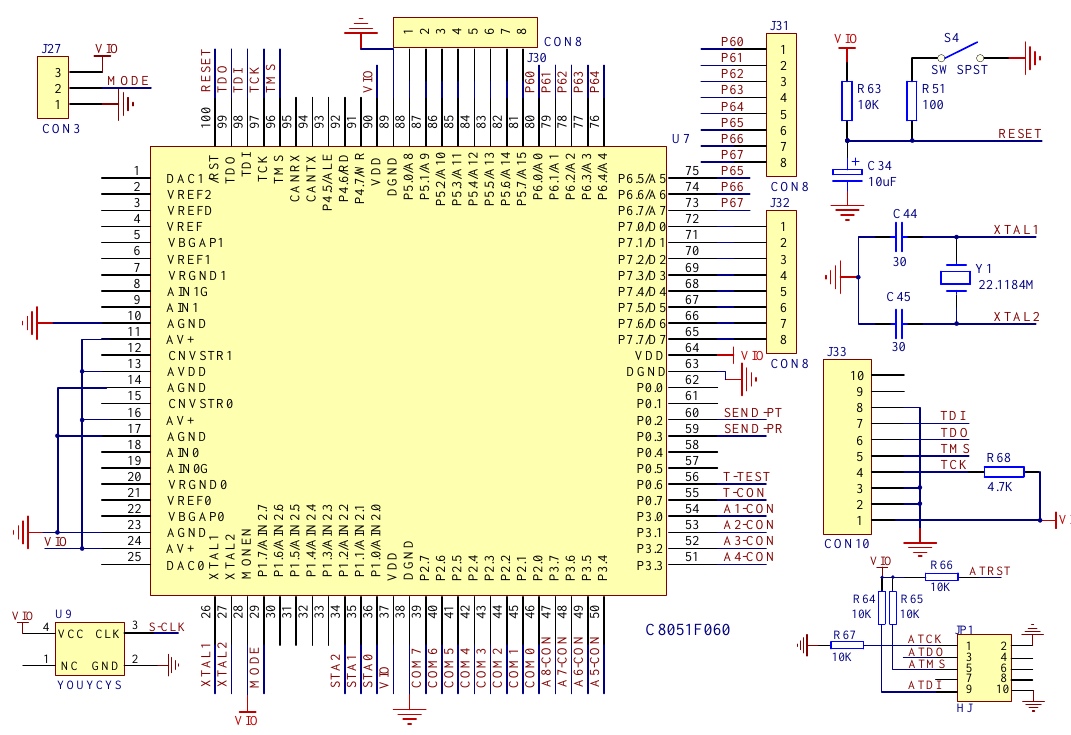
Figure 5. The schematics of microcontroller unit (MCU) control circuit.